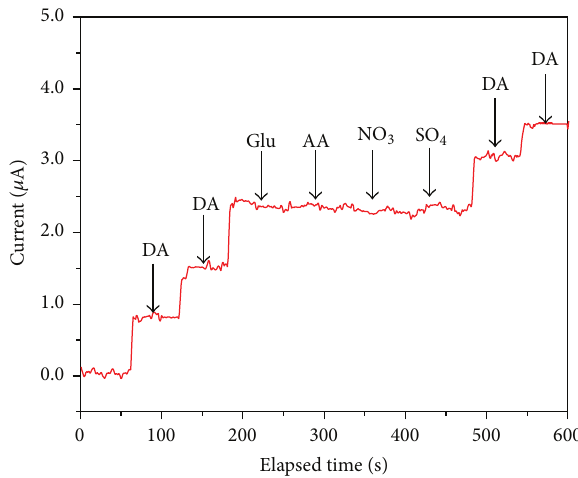
Figure 14: Chronoamperometric curve obtained for hematite- modified electrode upon addition of DA and interference sources, including ascorbic acid, glucose, sulphate, and nitrate, at applied potential of 200